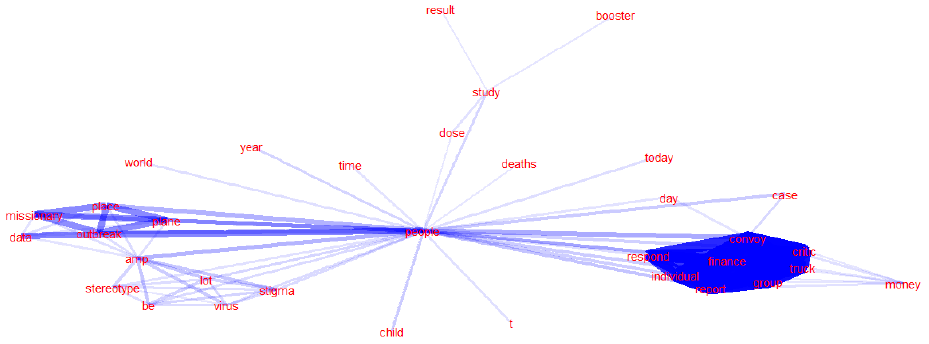
Figure 7. Word collocation of tweets posted by humans.